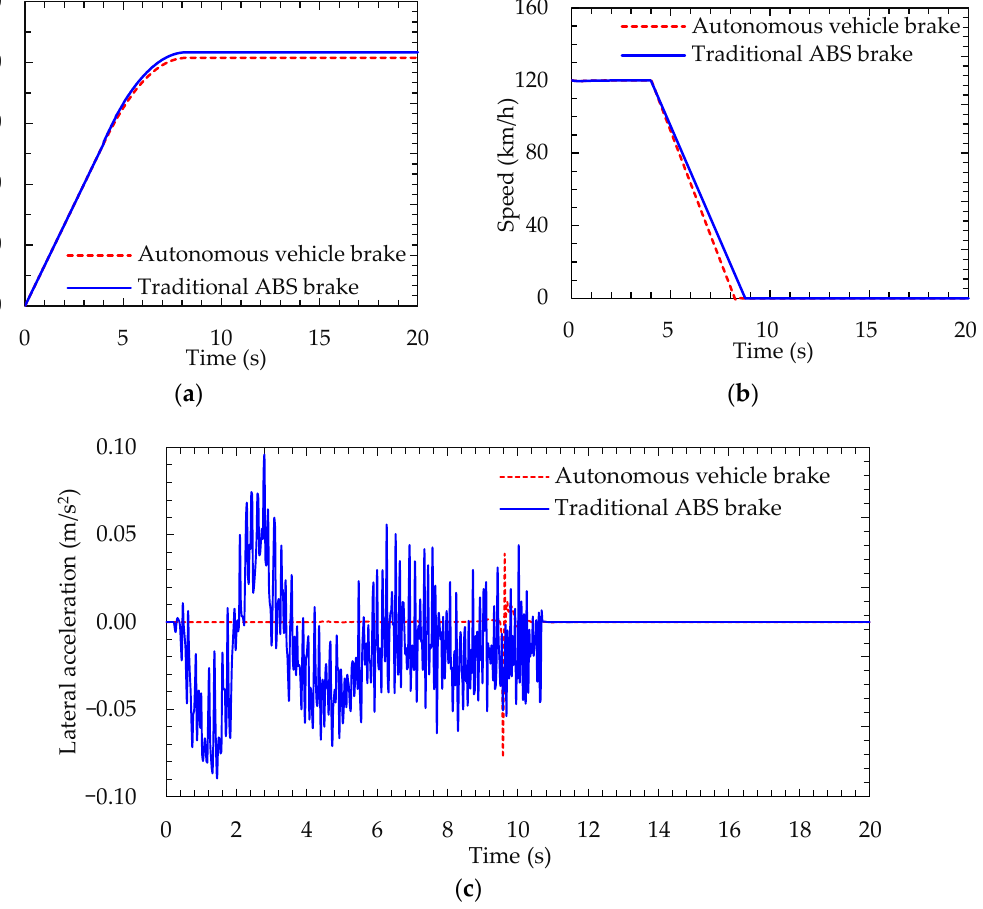
Figure 7. Braking performance analysis compared with a traditional vehicle: ( a ) speed–time curve; ( b ) braking distance–time curve; ( c ) lateral acceleration curve.